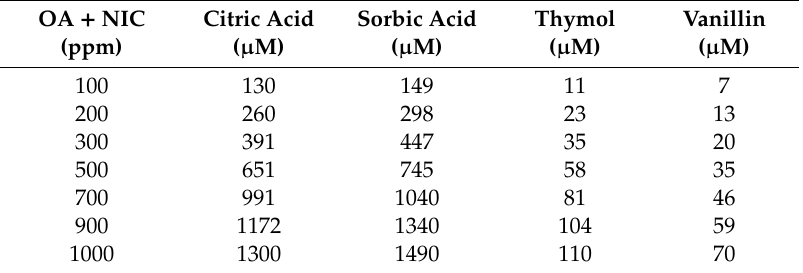
Table 2. Composition of the blend OA + NIC at the concentration tested for the viability assay. The inclusions of the single compounds in each row correspond to the amount of the molecules in the mixture (OA +